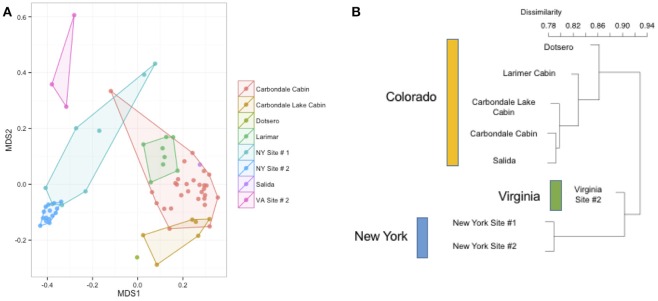
(A,B) Differences by site in Myotis lucifugus. Within a single species sampled across multiple states (M. lucifugus), site is very important in determining the beta-diversity of the bacterial community, as visualized in an NMDS ordination (stress = 0.14). (PERMANOVA R2: 0.33, p-value < 0.001). The clustering of the Virginia samples (upper left, in pink) and the New York samples (center, in blue) also shows the regional signal. At right, a dendrogram of the Bray-Curtis dissimilarity matrix for these sites.